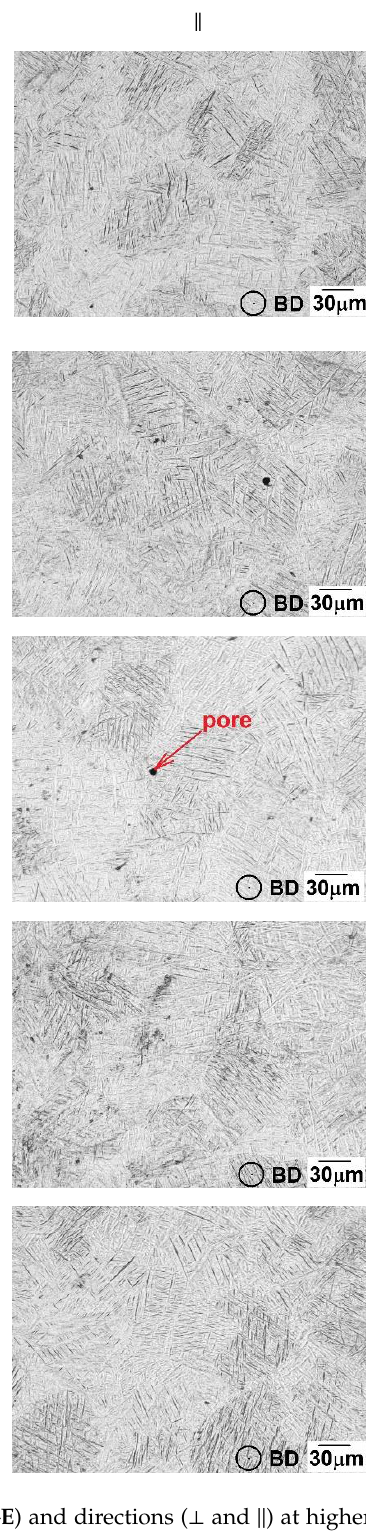
Figure 4. Micrographs of material in individual positions ( A – E ) and directions ( ⊥ and ‖ ) at higher magnification, LM, the arrow indicates build direction (BD).